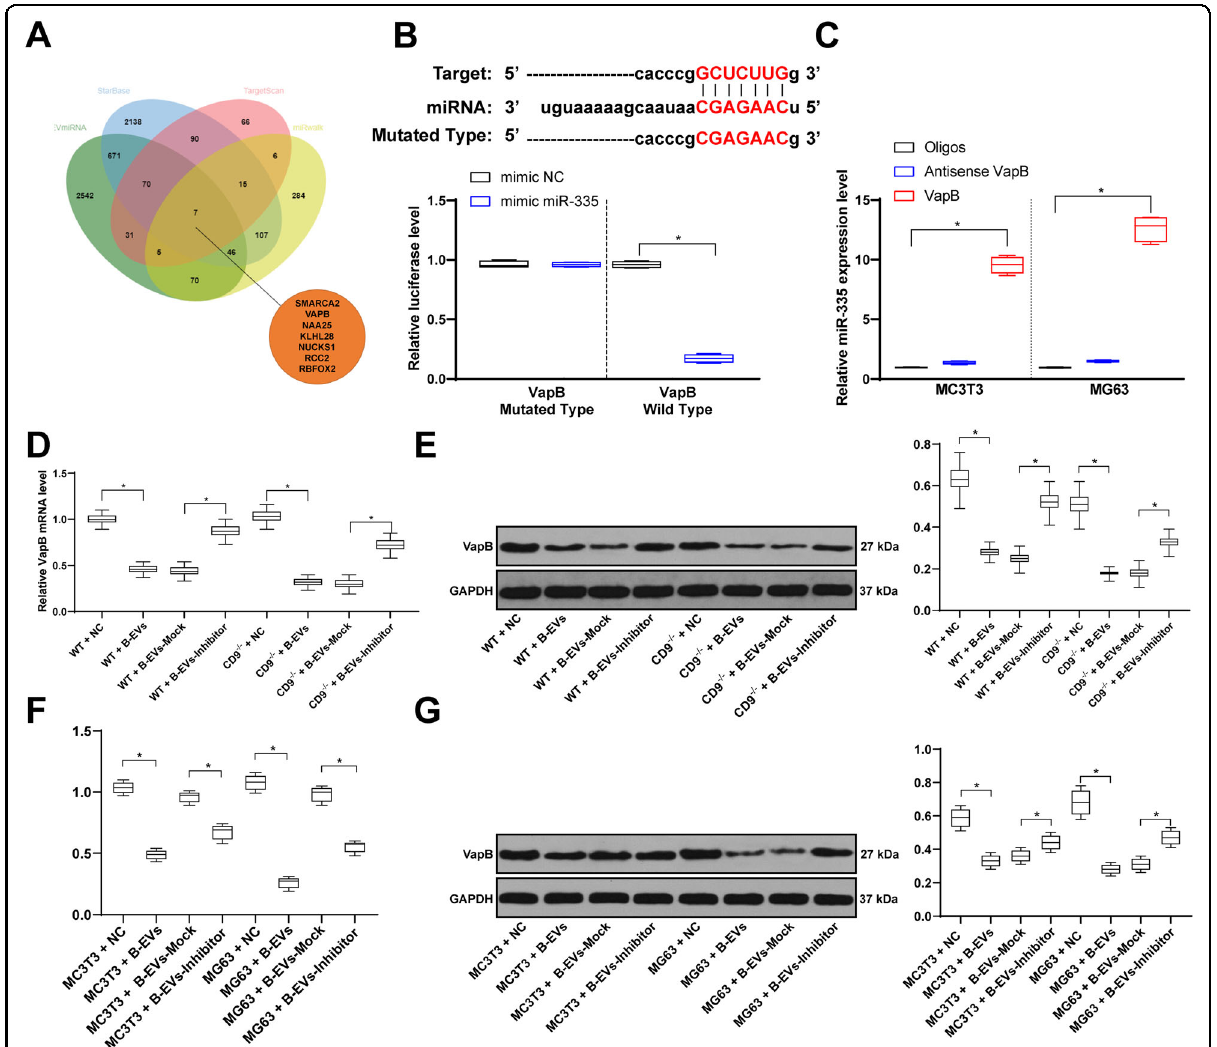
Fig. 6 miR-335 promoted bone fracture recovery via targeting VapB. A EvimicroRNA and Starbase predicted miR-335 target gene, and seven mRNAs were selected. B dual-luciferase reporter gene assay in HEK293T cells and C RNA pull-down assay were performed to validate the combination between miR-335 and VapB in MC3T3 and MG63 cells. VapB mRNA and protein levels in fracture mouse model ( D , E ) or MC3T3 and MG63 cells ( F , G ) were determined by RT-qPCR and western blot analysis. Data are expressed as mean ± standard deviation. Two-way ANOVA